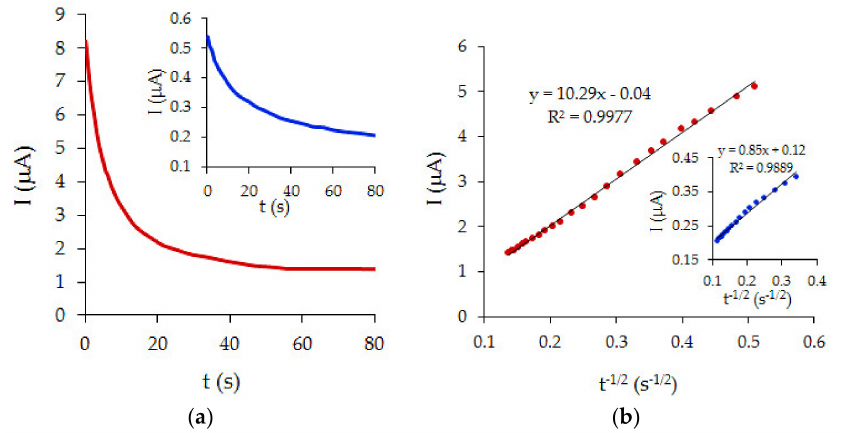
at di ff erent potential scan rates (0.02, 0.025, 0.04, 0.05, 0.075, 0.1, 0.15, 0.25 Vs − 1 ) ( a ) and dependence of the oxidation peak potential on the natural logarithm of the potential scan rate ( b ).